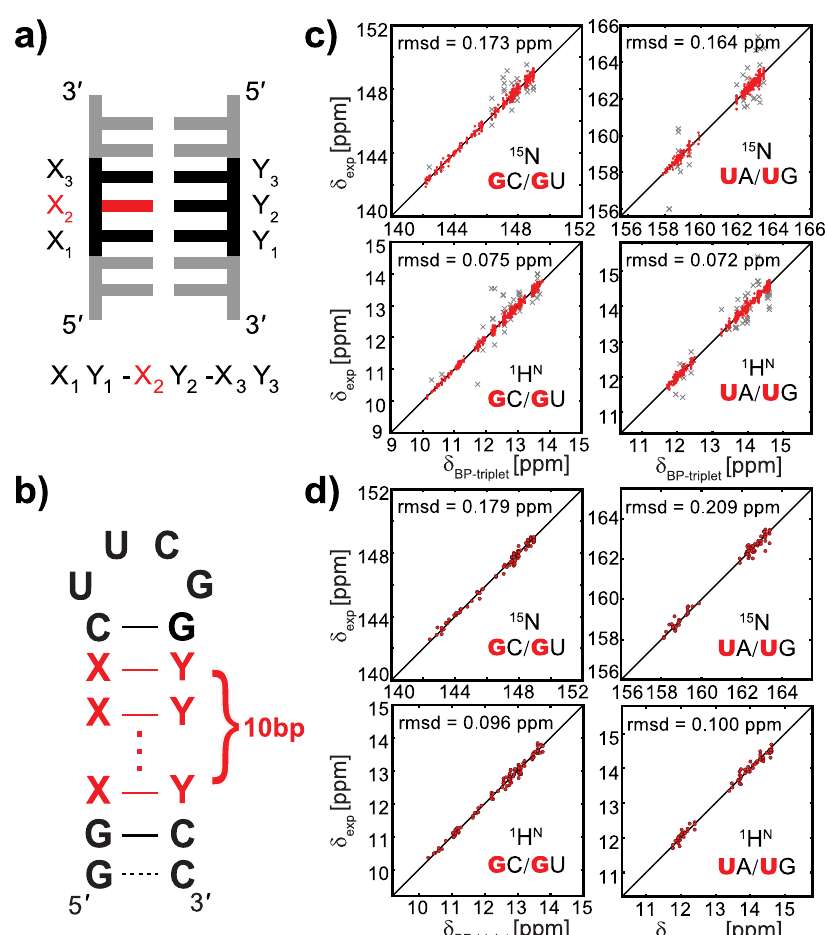
Fig. 1 Prediction of imino chemical shifts using the base pair triplet (BP-triplet). a De fi nition of BP-triplet where the nucleotide under measurement is colored in red. Each BP-triplet can be described by a three- fi eld code: the left fi eld represents 5 ′ neighboring base pair judging from the nucleotide of interest, while the right fi eld represents the base pair to the 3 ′ direction. b RNA hairpins used for collecting imino chemical shift data. Base pairs in the stem region (red) are designed to produce as many different BP-triplets as possible. For a few hairpin samples, the UUCG apical loop is replaced with an AACGU pentaloop, and eight base pairs instead of ten are placed in the stem region (see Supplementary Tables 1 and 3). c Correlation between predicted and experimental 15 N (upper panel) and 1 H N (lower panel) chemical shifts for BP-triplets centered with GC/GU (left) and UA/UG (right) in the training dataset. The outliers (x marker in gray) are identi fi ed by the 3 σ rule and excluded from statistics. The overall rms deviations for 15 N and 1 H N are 0.169 and 0.073 p. p.m., respectively. d Correlation between predicted and experimental 15 N (upper panel) and 1 H N (lower panel) chemical shifts for BP-triplets centered with GC/GU (left) and UA/UG (right) in the testing dataset. The overall rms deviations for 15 N and 1 H N are 0.193 and 0.097 p.p.m.,